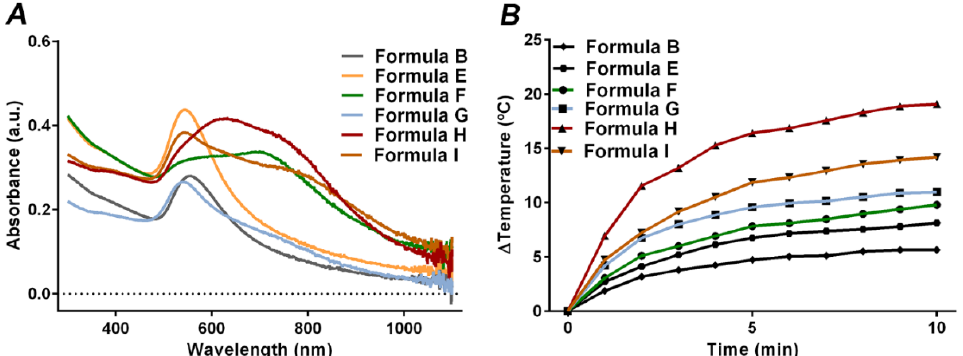
Figure 4. Characterization of the PTT capacity of AuMSS nanoclusters. ( A ) UV-Vis-NIR spectra of different nanoformulations of AuMSS nanoclusters; ( B ) Temperature variation curves of AuMSS nanoclusters in ultrapure water, NIR laser (808 nm, 1.7 W cm −2 ) irradiation for 10 min. Data are presented as mean ± s.d., * p < 0.05, n = 3.